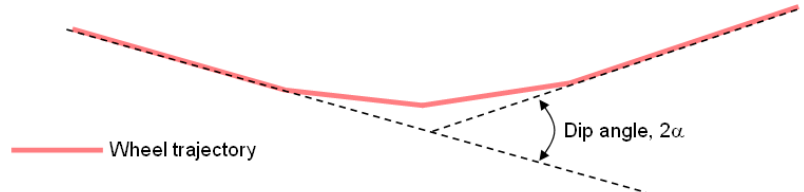
Figure 2. Transfer zone at crossing where a conical wheel traversing a v-crossing (removal of white paint showing the wheel contact band) and running over a dip angle inducing impact force. Note that axle box acceleration responds only to the wheel trajectory path, which is the gross resultant of combined degradations of crossings, pads, bearers, ballast, and support formation.